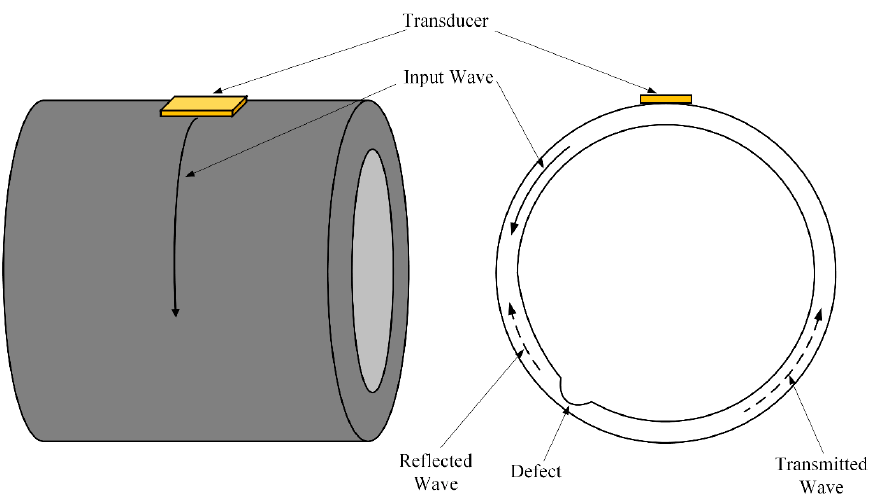
Figure 2. Schematic of circumferential guided-wave-based SHM approach.